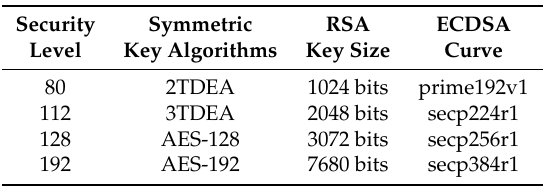
Table 1. Comparable strengths for symmetric, RSA and ECDSA ciphers [30].